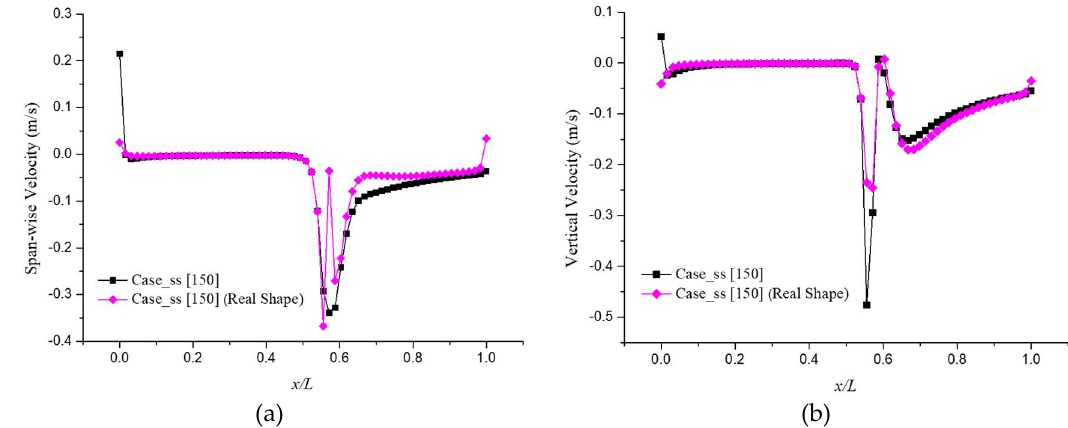
Figure A1. Model and grid distribution in real shape case in preliminary test.